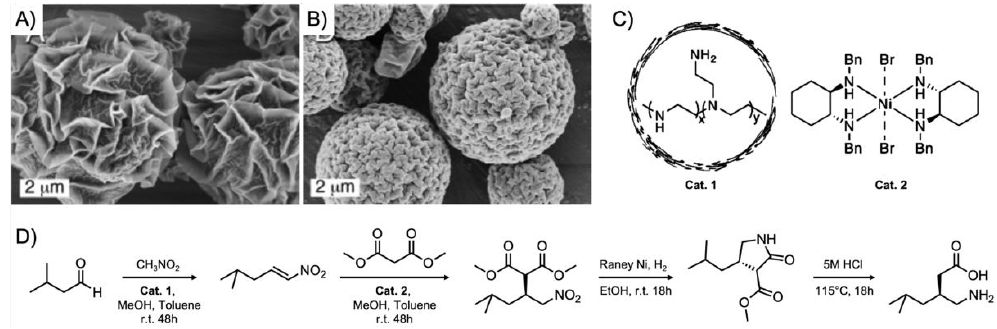
Figure 17. Catalytic reactions in microcapsules. ( A , B ) Microcapsules with different wall thickness through interfacial cross-linking of PMPPI and TEPA. ( C ) PEI and nickel-based catalysts. ( D ) Synthesis of Pregabalin from 3-methylbutyraldehyde, nitromethane and dimethyl malonate. Adapted with permission of [144] and [146]. Copyright 2006 and 2007 American Chemical Society.